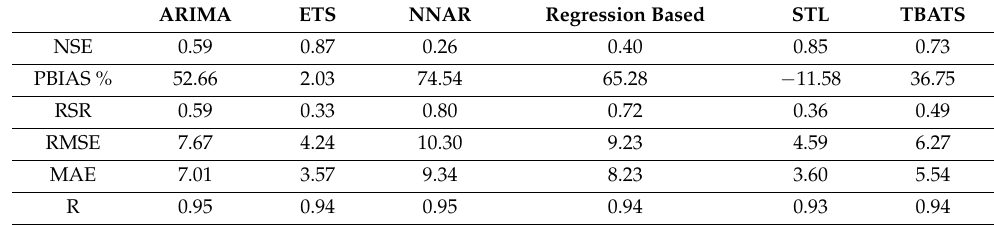
Figure 7. Comparison of forecast performances between observed (GRACE) and forecast (six stochastic models) TWSA from November 2019 to May 2020. The following stochastic models are used: ( a ) ARIMA (Autoregressive integrated moving average); ( b ) ETS (Error, Trend, Seasonal or the Exponential Smoothing); ( c ) NNAR (Neural Network Autoregression); ( d ) Reg. based (time-series regression based); ( e ) STL (Seasonal and trend decomposition through Loess smoother) and ( f ) TBATS (T for trigonometric regressors to model multiple-seasonalities; B for Box–Cox transformations; A for ARMA errors; T for trend; S for seasonality). 95% confidence interval is shown as patterns. Table 1. Performance statistics of 6 statistical forecasting methods used for TWSA forecasting.